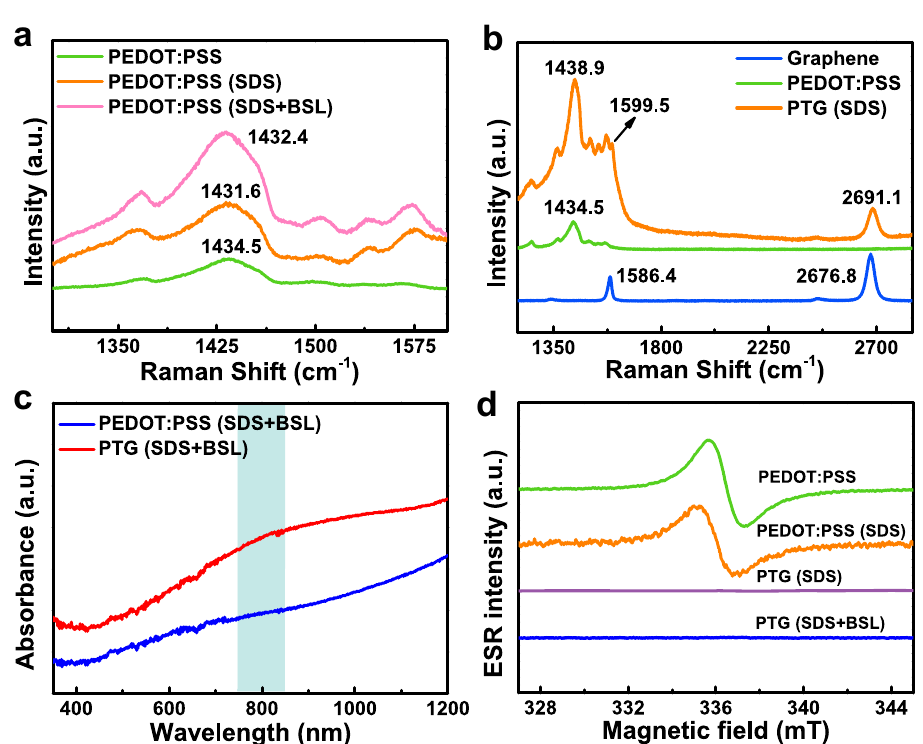
Fig. 3 Synergistic enhancement between PEDOT:PSS and graphene. a Raman spectra of PEDOT:PSS fi lms with different additives. b Comparison of Raman spectra of graphene, pristine PEDOT:PSS and PTG fi lms. c UV – vis-NIR spectra of pure PEDOT:PSS and PTG fi lms. d ESR spectra of various PEDOT: PSS and PTG fi